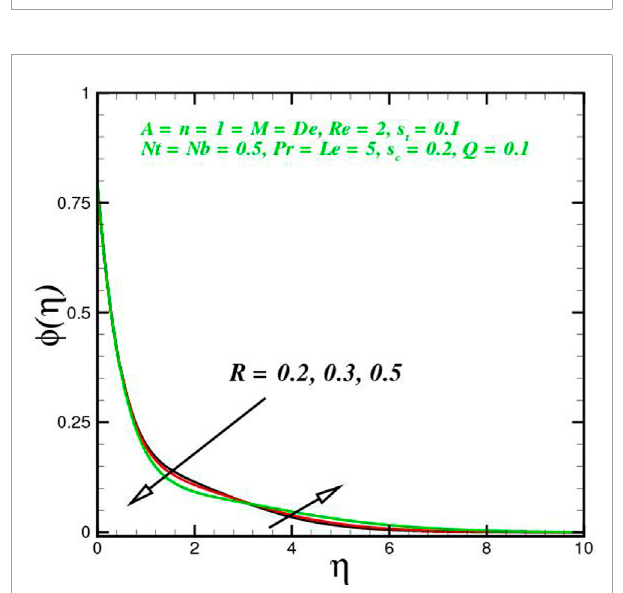
FIGURE 11 ϕ ( η ) , alteration via R.